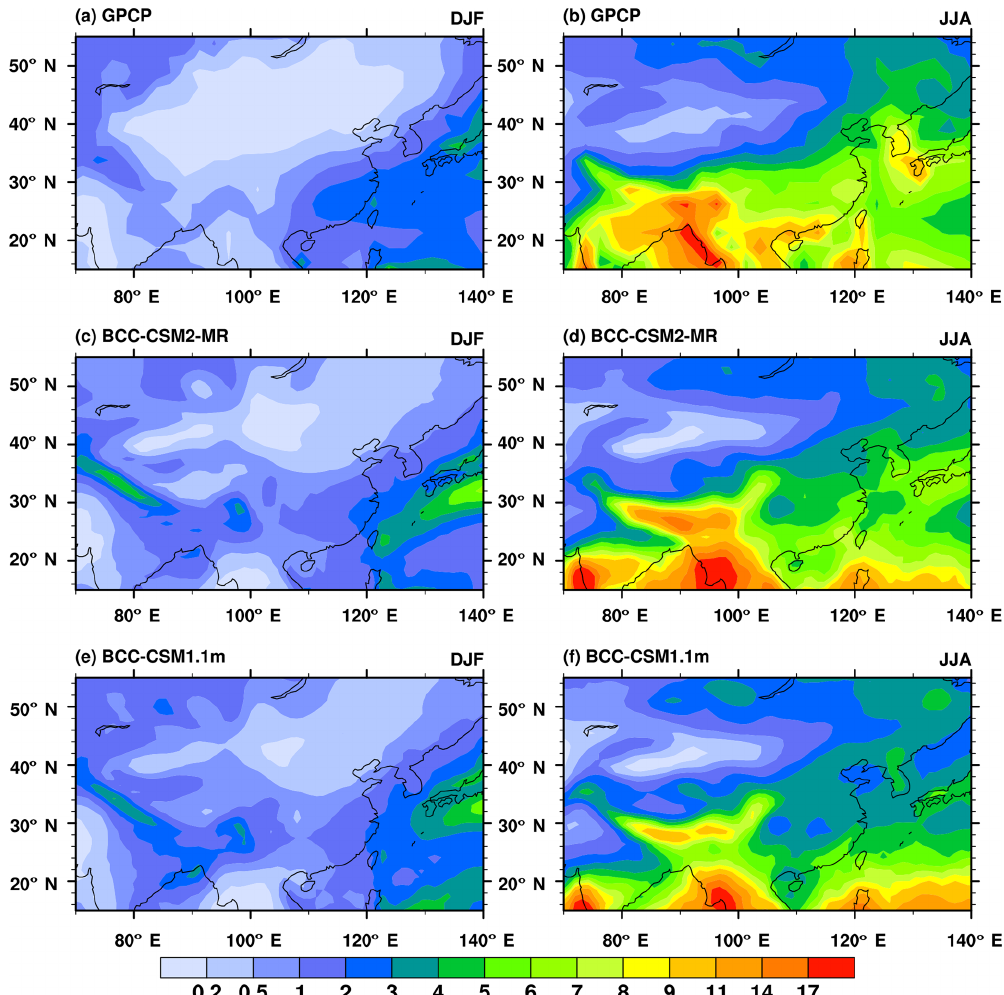
Figure 18. Regional distribution maps of precipitation climatology (averaged from 1980 to 2005) for December–January–February (a, c, e) and June–July–August (b, d, f) from (a) GPCP, (b) BCC-CSM2-MR, and (c) BCC-CSM1.1m. (Units: mmday − 1